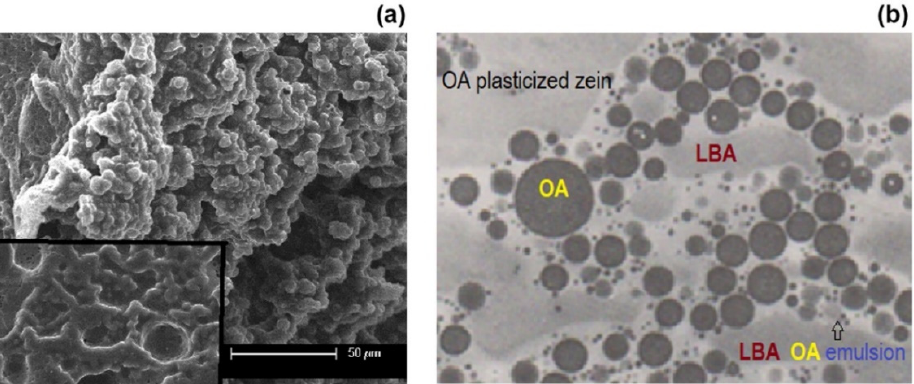
Figure 6. Morphological features of zein-LBA-OA films: ( a ) SEM image of a fractured sample before extraction, with inset for a surface image after extraction; scale bar: 50 µm. ( b ) Schematic illustration, which is based on TEM images of morphologically complex polymer alloys, such as blends of polycarbonate (PC) and ABS (acrylonitrile-styrene-butadiene terpolymer), containing encapsulated rubber particles within a continuous matrix of miscible PC/SAN [37].